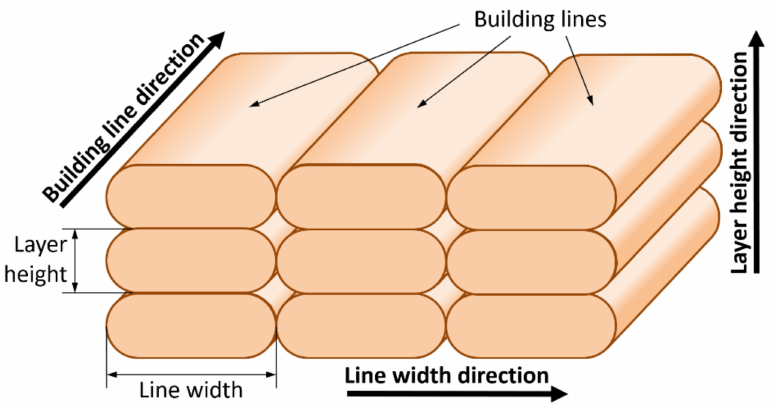
Figure 2. Building line dimensions.